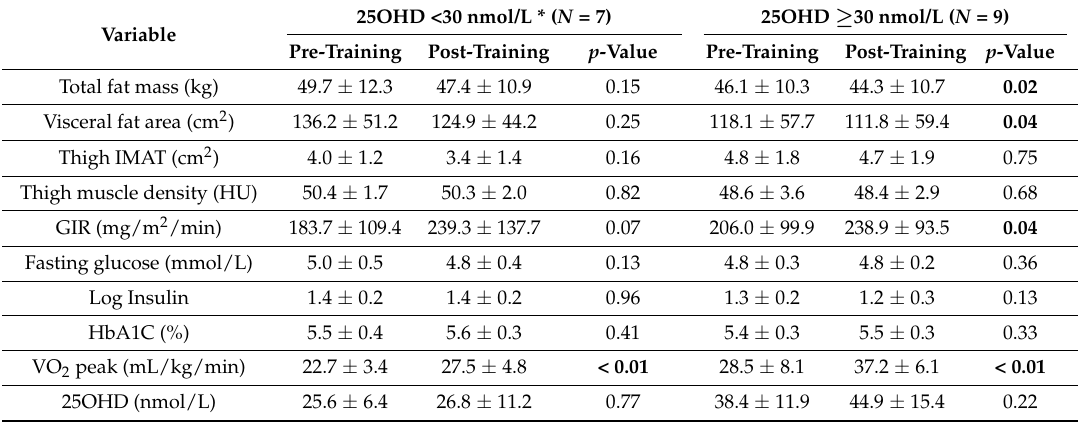
Table 3. Comparison of pre-training and post-training values for body composition and cardiometabolic parameters according to pre-training vitamin D